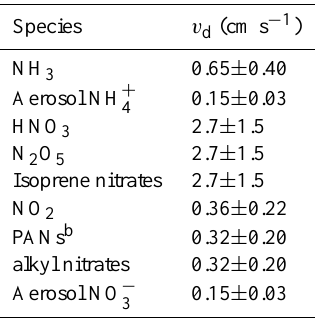
Table 1. Mean daytime dry deposition velocities over the contigu- ous US a .